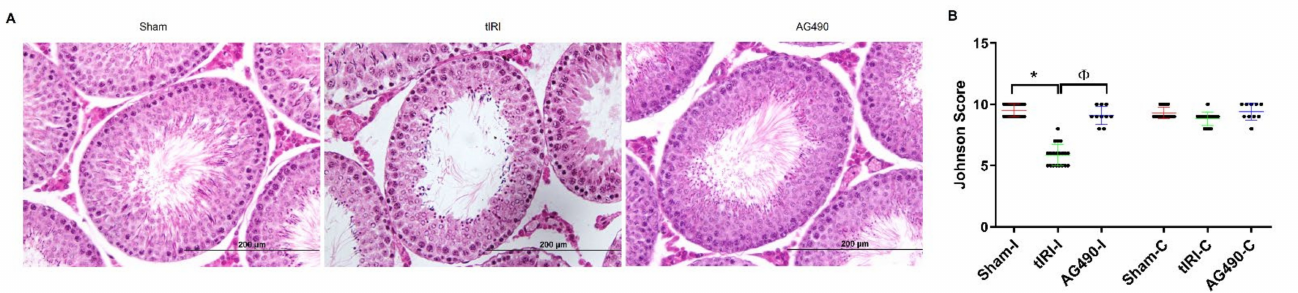
Figure 2. JAK2 inhibition prevents tIRI-induced spermatogenic arrest. ( A ) H&E stained sections of ipsilateral testes with 40x magnification representing the histological differences in the three experimental groups. Sham group sections had normal ST structure and spermatogenesis while the tIRI sections demonstrated disrupted tubular structure and disarrangement of germ cell layers. The AG490-treated tissue sections showed conserved morphology of the STs similar to sham group. ( B ) Graphs representing the histological analyses in ipsilateral and contralateral testes using the Johnsen score. The ipsilateral testis of tIRI group showed a lower Johnsen score when compared to * sham and Φ AG490-treated groups (Johnsen score: * p < 0.0001, Φ p < 0.0001, respectively). The contralateral testes in all groups showed no significant differences in the Johnsen score ( p > 0.05). Data are presented as mean ± SD ( n = 6/group). * tIRI compared to sham and Φ AG490 compared to tIRI. I = Ipsilateral and C =